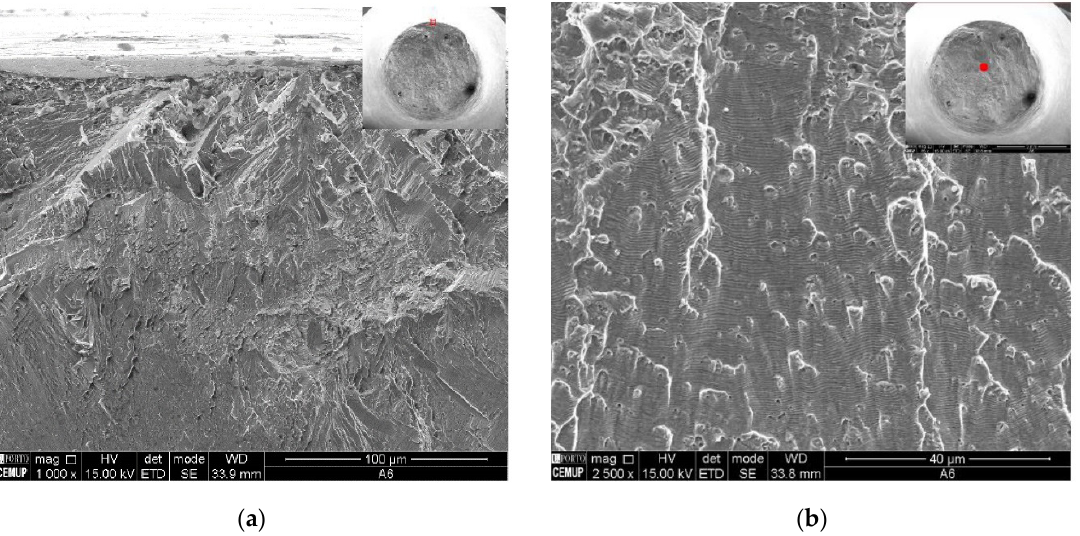
Figure 18. Fracture surfaces for standard axial fatigue sample, sample A6, maximum stress = 685 MPa: ( a ) Crack nucleation region; ( b ) Transcrystalline fatigue crack growth region.